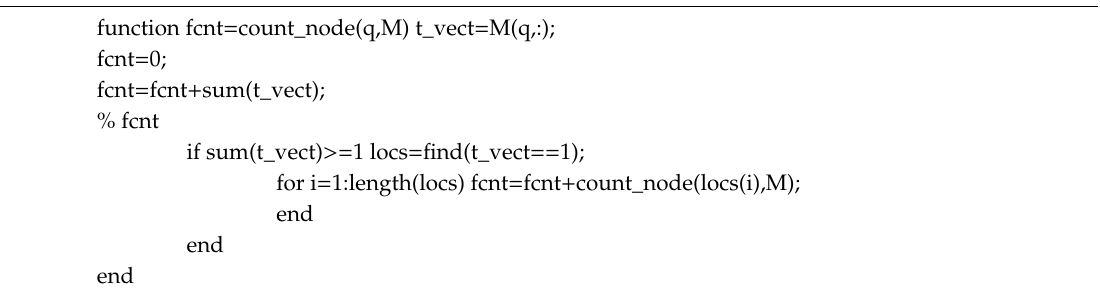
Algorithm 1: Function for counting the number of nodes connected at the downstream node end of the